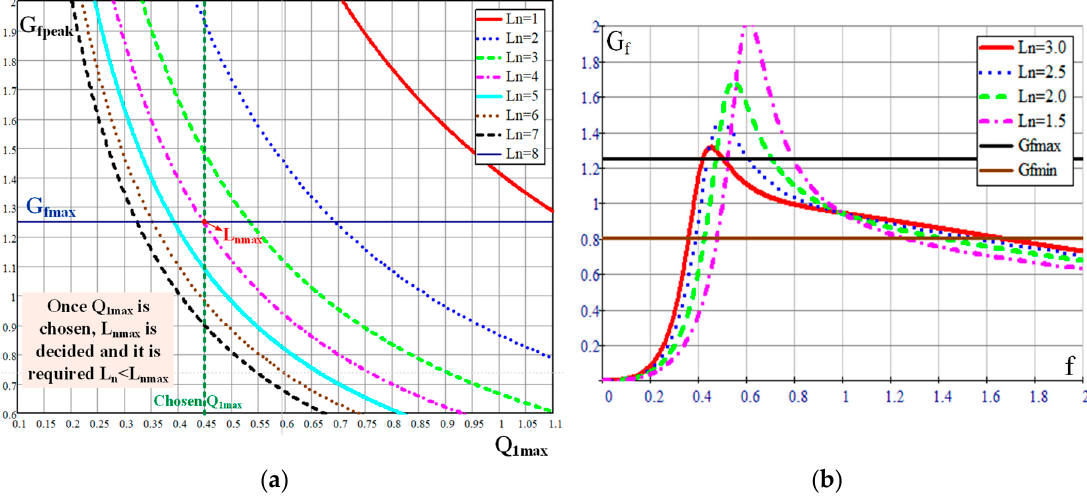
Figure 8. Gain curves used to determine Q 1max and L n . ( a ) Curve family of DC gain curves with various Q 1max and L n ; ( b ) Curve family of DC gains with various f and L n .